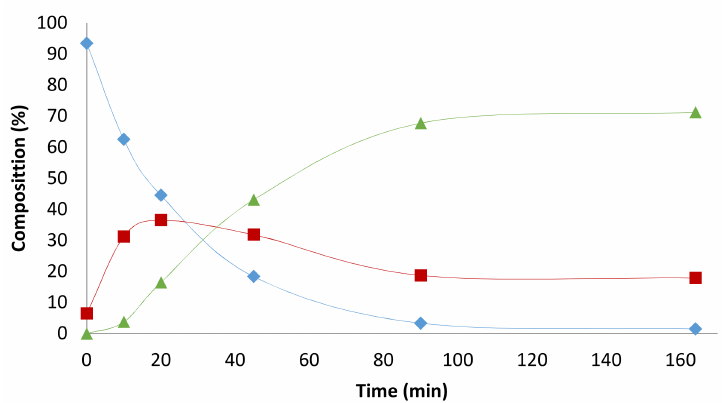
Figure A6. Composition profiles during the tandem hydroformylation-isomerization of 10-undecenitrile with Rh-biphephos in toluene at [ 1 ] 0 /[Rh] = 3000 at 10 bar CO + 30 bar H 2 ( (cid:7) 1 , (cid:4) 1- int -x , (cid:78) 2 + 3 ) (Table 3, entry